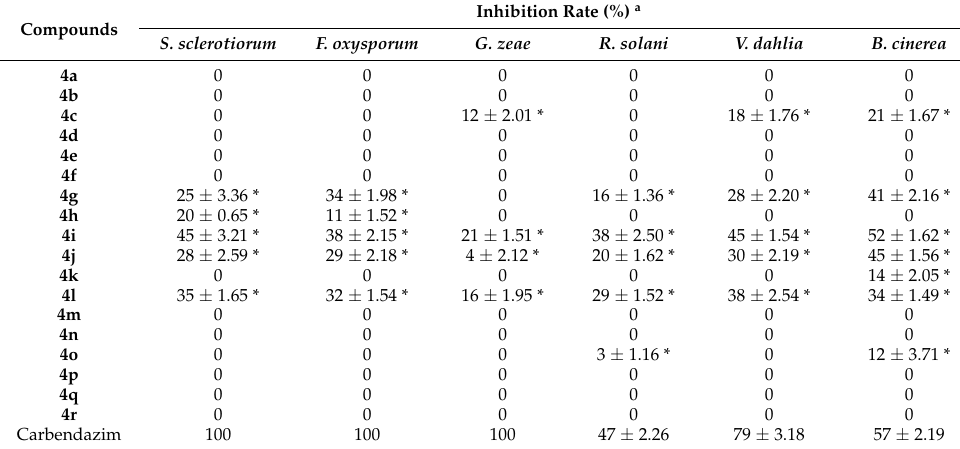
Table 3. In vitro antifungal activities of the target compounds 4a – 4r against Sclerotinia sclerotiorum, Fusarium oxysporum, Gibberella zeae, Rhizoctonia solani, Verticillium dahlia, and Botrytis cinerea at 50 µ